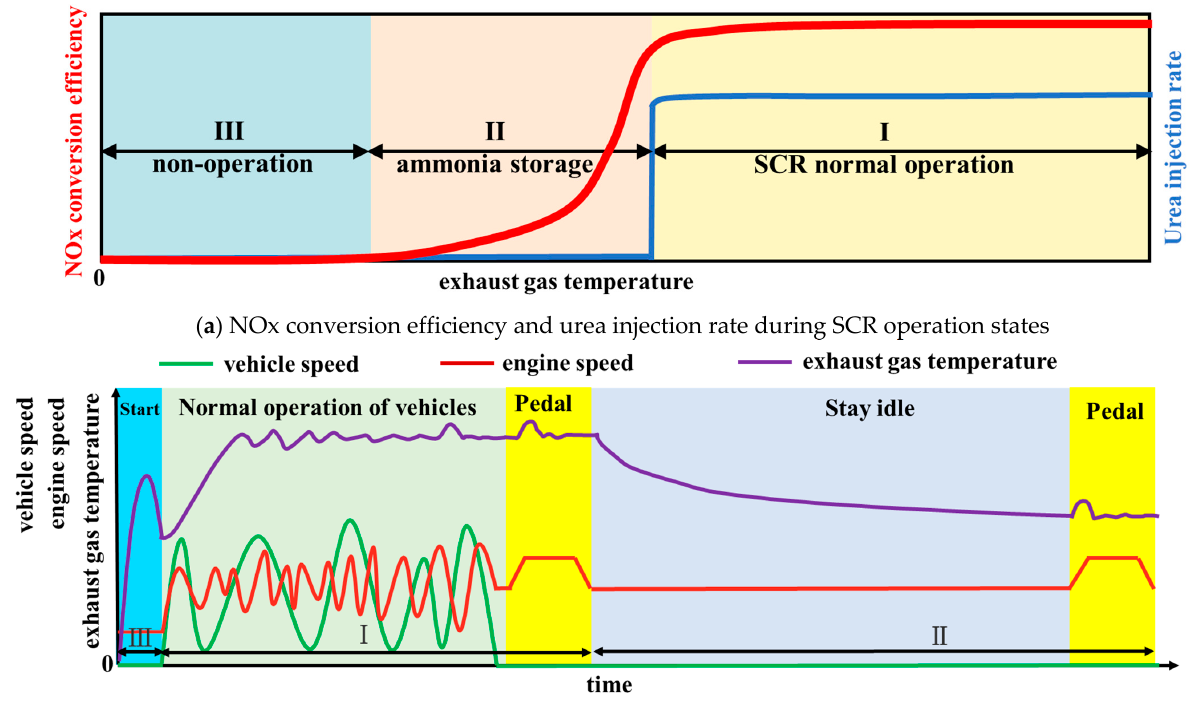
Figure 1. Proposed real-road test method based on operation states of the SCR system.